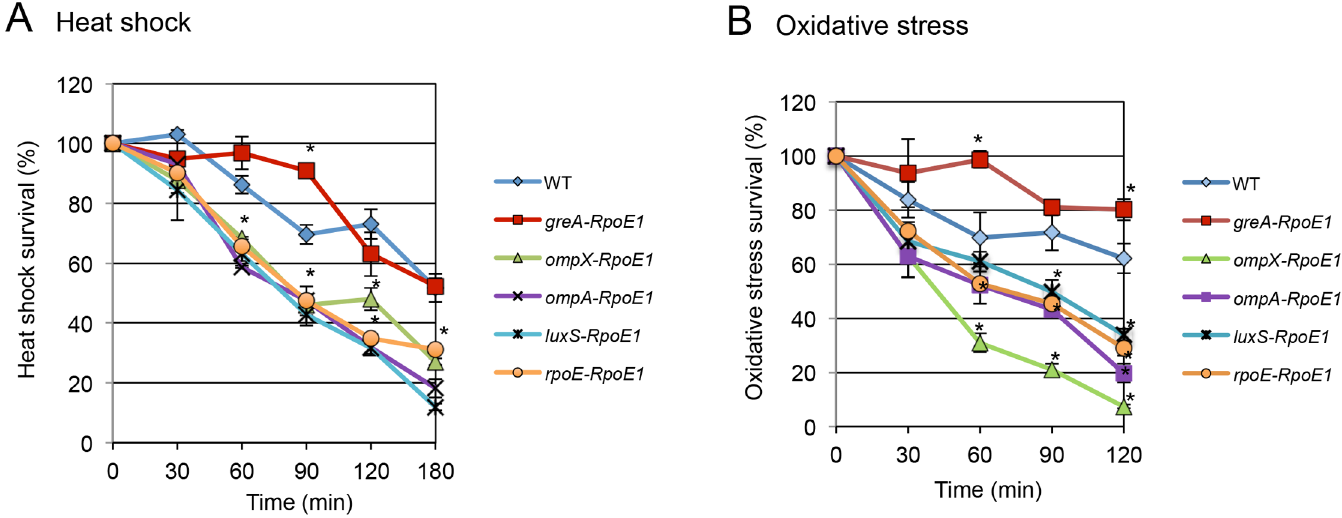
Fig 7. Heat shock and oxidative stress susceptibility. WT and mutant strains with substituted σ E consensus sequences (refer to Fig 5. for details) were cultured in LB broth overnight, washed with and re-suspended in M9 minimal medium before challenging with heat shock (48°C) (A) or oxidative stress (5 mM H 2 O 2 ) (B) The mean and S.D. values were obtained from three independent